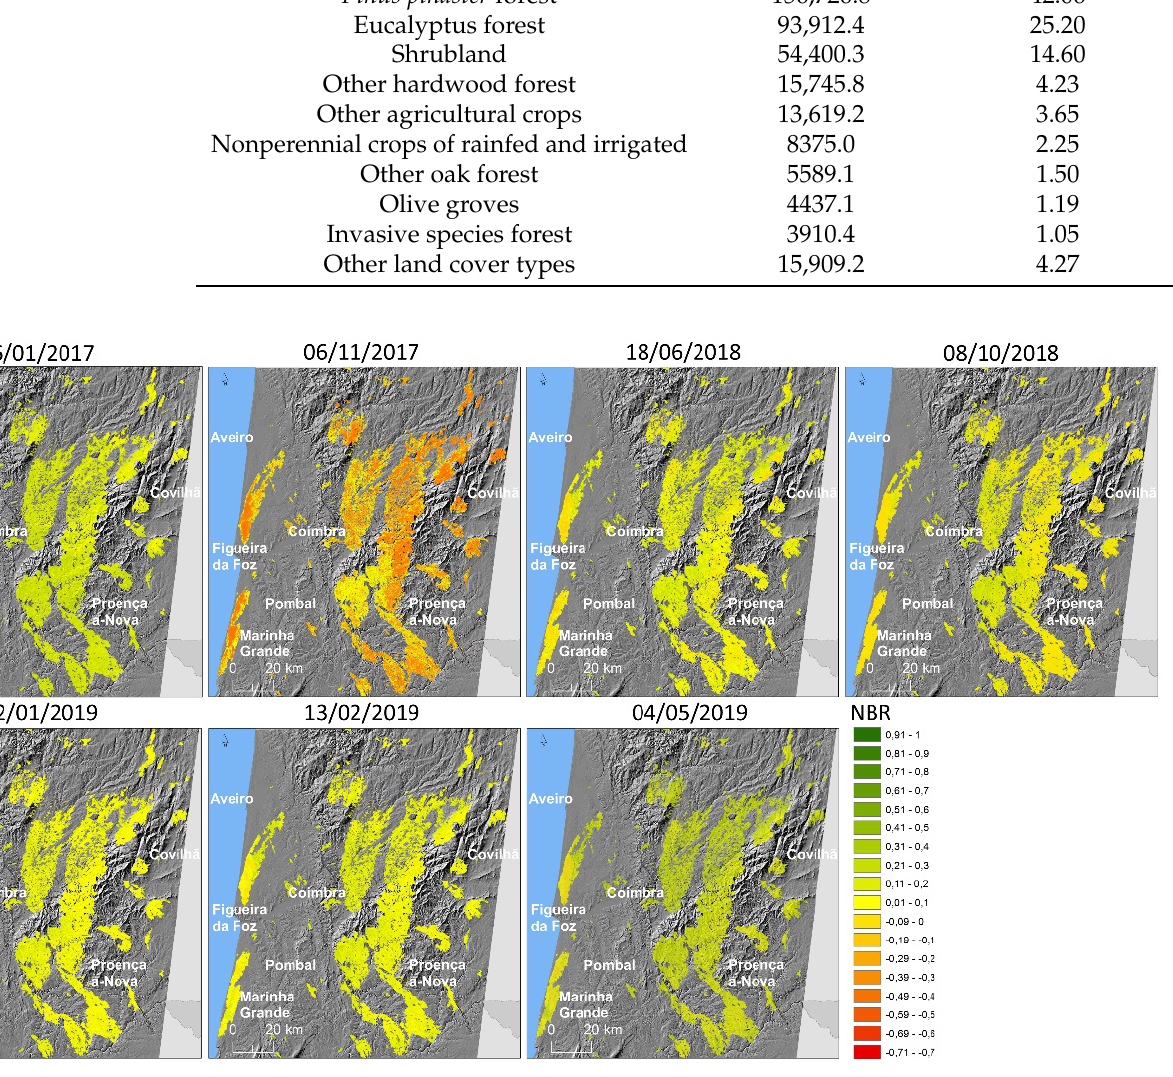
Figure 4. Normalized Burned Ratio index (NBR) in burned areas of wildfires of 2017.